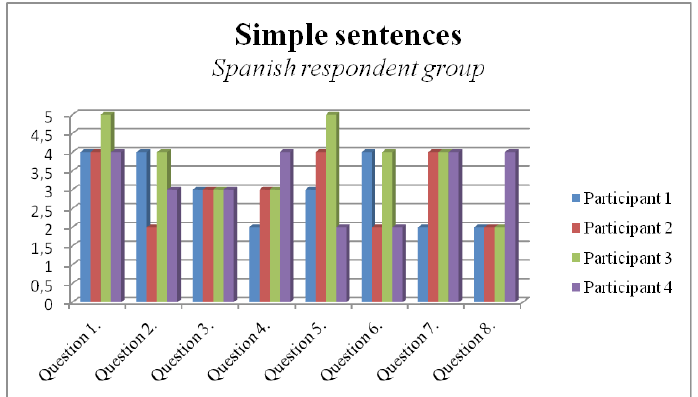
Graphic 9: Simple sentences - Spanish respondent group.